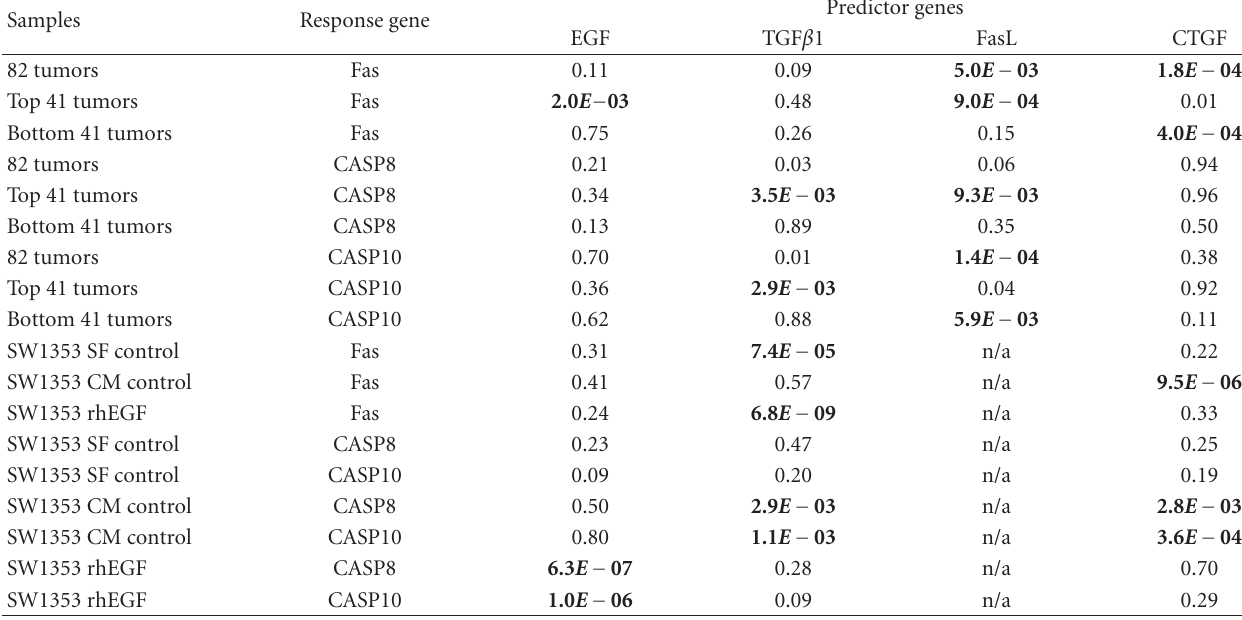
Table 5: Predictive value of EGF, TGF β 1, CTGF, and FasL for Fas, CASP8, and CASP10 mRNA concentrations in sarcomas and in serum-free (SF) and complete medium (CM) control and rhEGF-treated SW1353 chondrosarcoma cell cultures. Refer to Section 3.3 for separation of tumors into “top 41” and “bottom 41” tumor subcohorts. Significant probability values are in